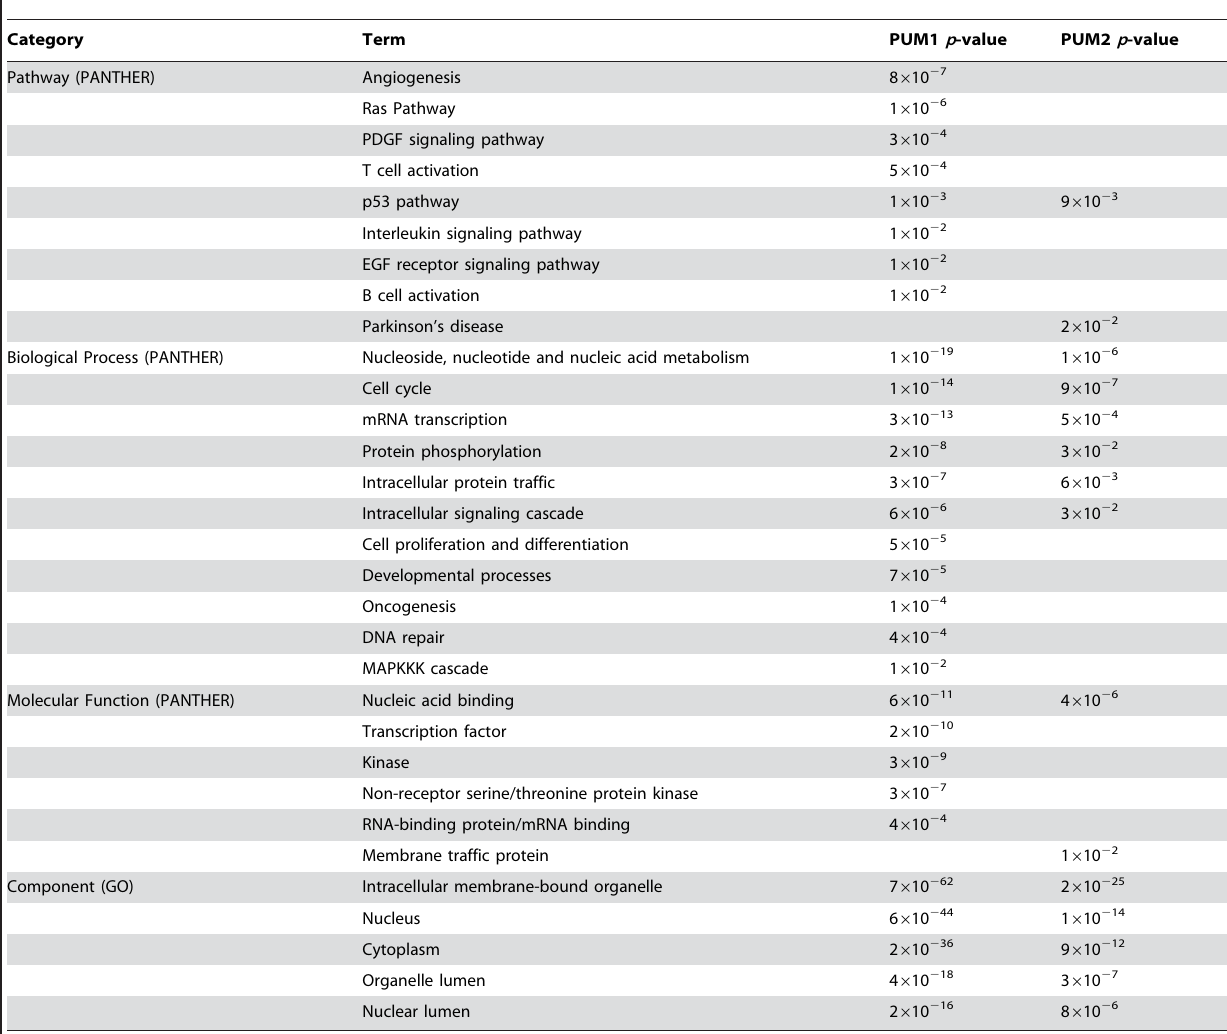
Table 1. Significantly shared PANTHER and GO annotations among PUM1 and PUM2 mRNA